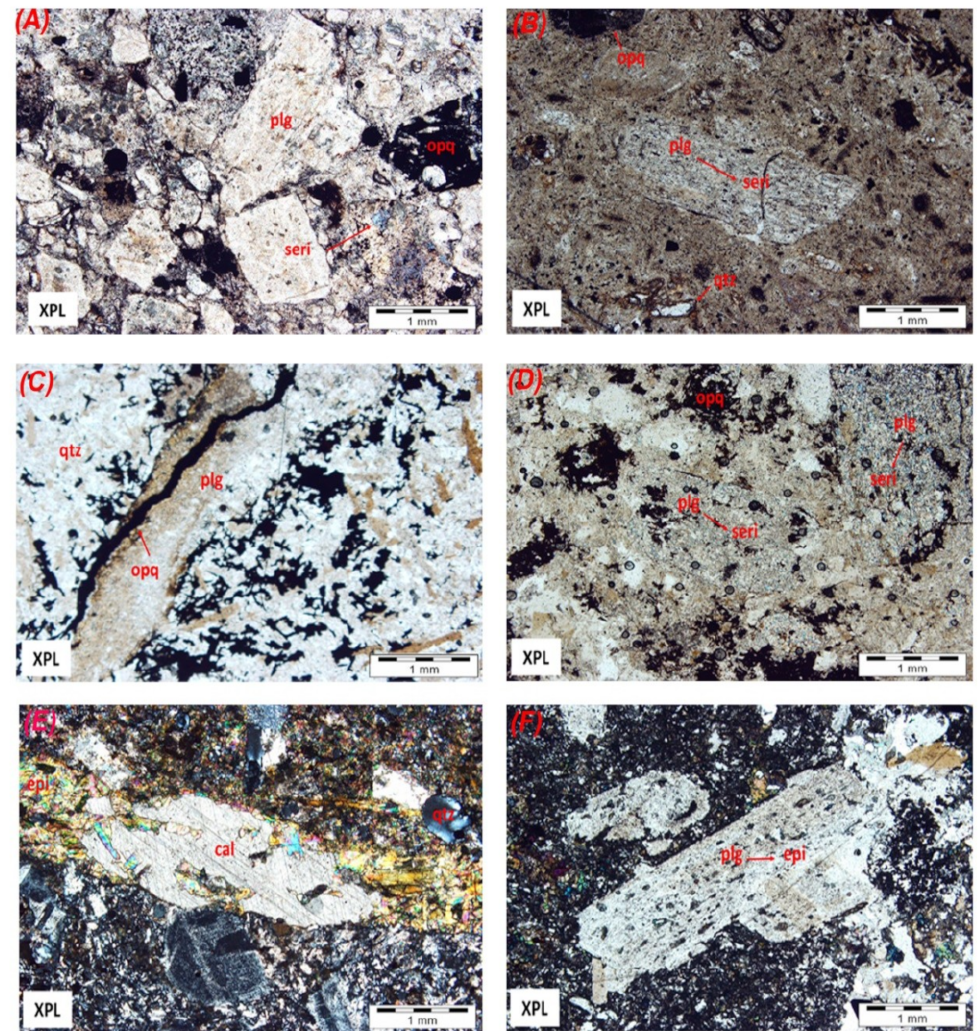
Figure 11. Different types of alteration mineralogy in the alteration zones. Microphotographs of ( A ) argillic zone: plagioclase has been replaced by sericite and clay mineral groups; ( B ) advanced argillic zones: plagioclase crystals topotactically replaced by sericite and clay mineral groups; ( C ) phyllic zone: vein of opaque minerals and relicts of plagioclase that replaced by clay mineral groups and quartz; ( D ) phyllic zone: relicts of plagioclase replaced by sericite; ( E ) propylitic zone: completely replaced original mineralogy by calcite, epidote, and quartz; ( F ) propylitic zone: variolitic to sub-ophytic texture of plagioclase phenocrysts replaced by epidote. Abbreviation: plg = plagioclase, seri = sericite, opq = opaque minerals, qtz = quartz, epi = epidote, cal =